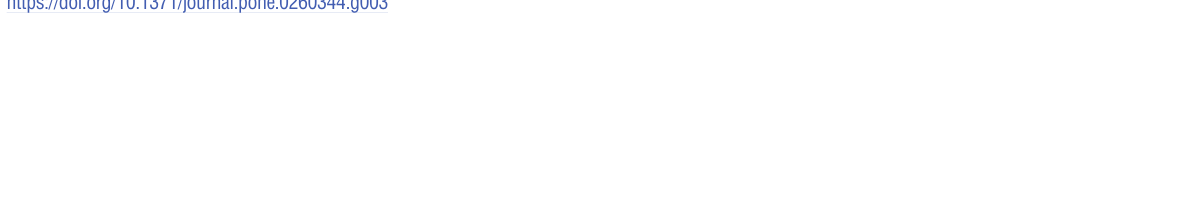
PLOS ONE | https://doi.org/10.1371/journal.pone.0260344 December9, 2021 10 /